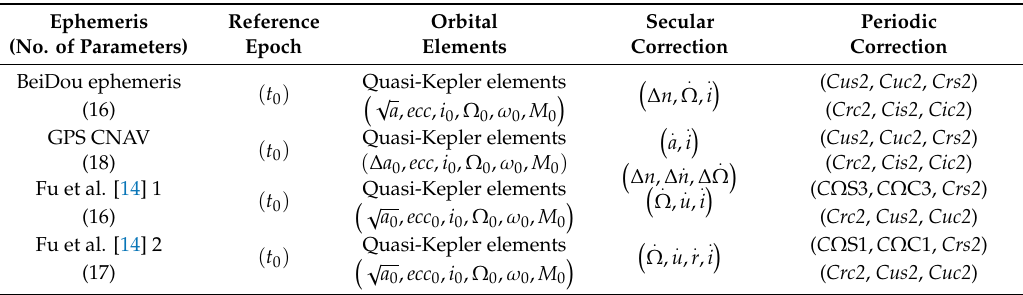
Table 6. Main differences in parameters and characteristics of competitive ephemeris models. GPS, global positioning system.